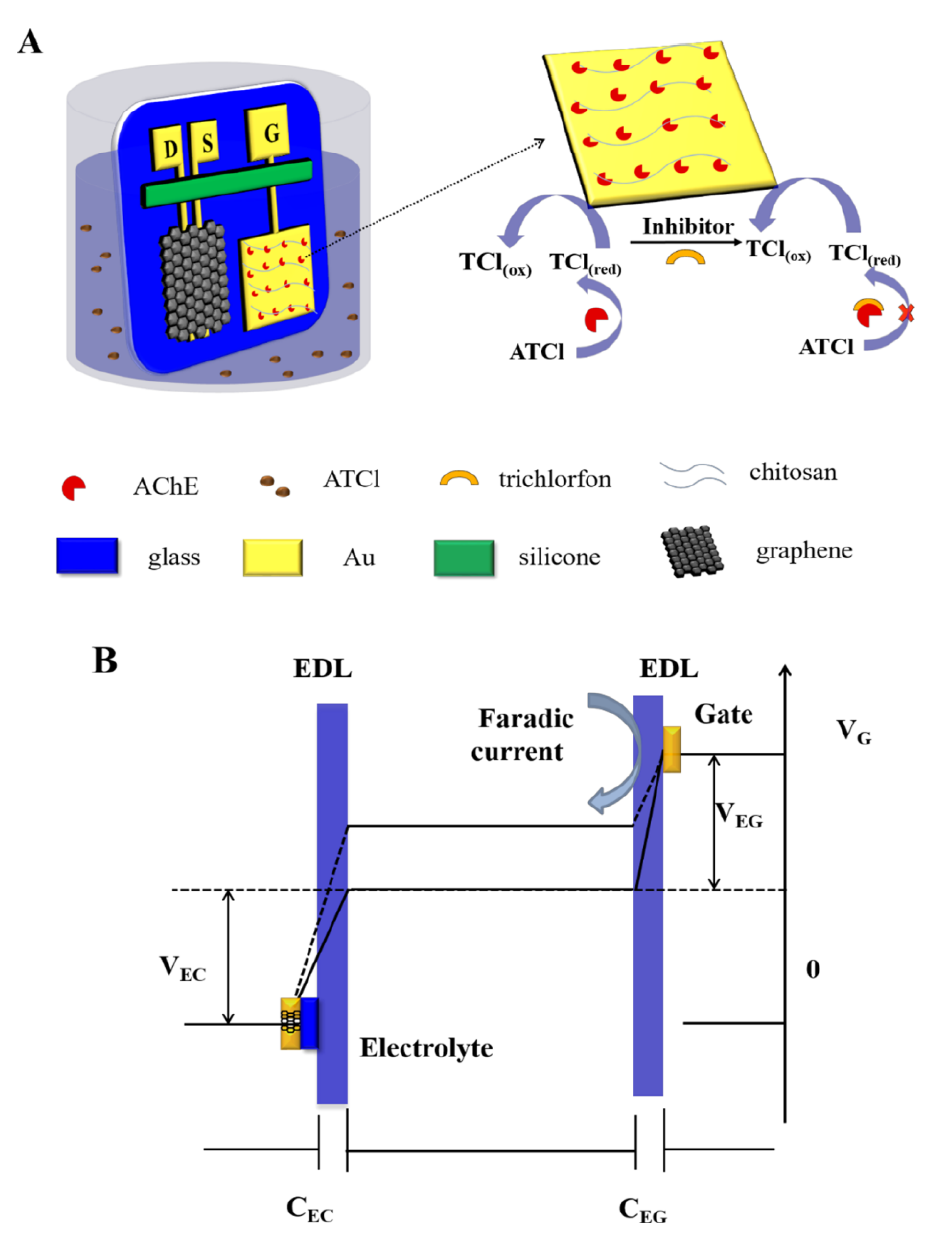
Figure 5. ( A ) Schematic representation of OP biosensor with immobilization of acetylcholinesterase (AChE) on a gold gate electrode with chitosan. D, S, and G represent the drain, source, and gate, respectively. ( B ) Representation of the potential drop between the gate and the graphene channel. Solid line represents the potential drop before the addition of trichlorfon in PBS solution, and dashed line represents the potential drop after the addition of trichlorfon in PBS solution. Reprinted with permission from [52]. Copyright© 2021 American Chemical Society.